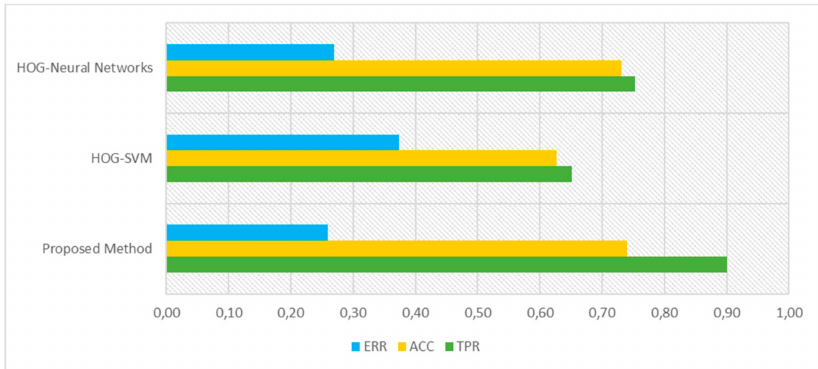
Figure 7. Selected quality measures for HOG-SVM, HOG-neural networks, and the proposed